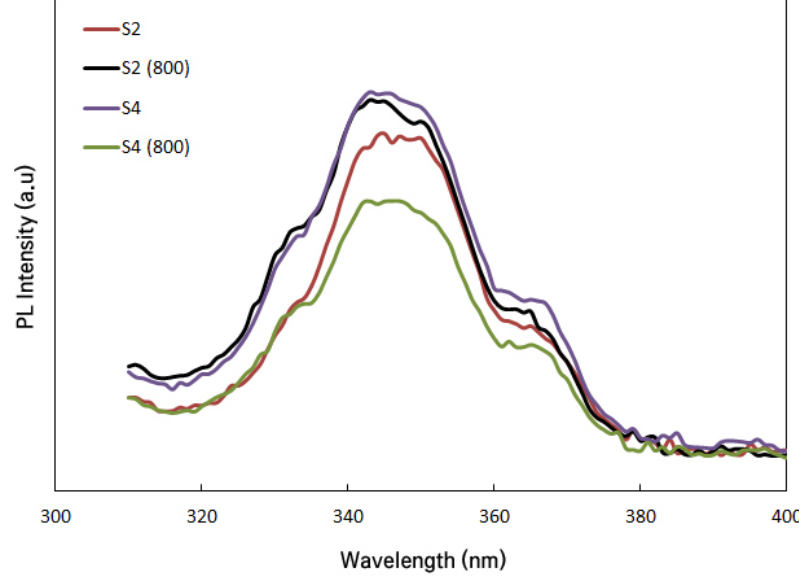
Figure 10. Photoluminescence spectrum of S2, S4, S2(800) and S4(800).